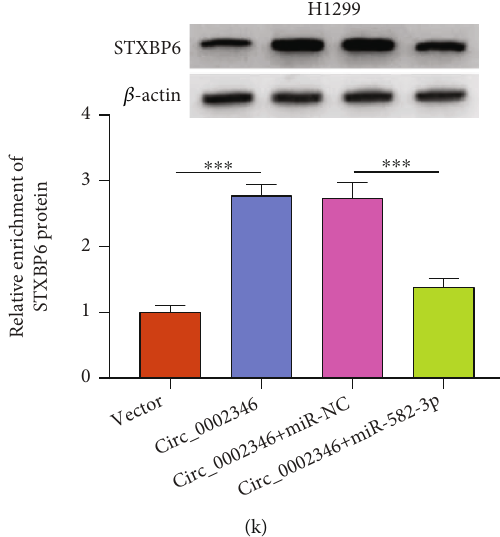
Figure 5: STXBP6 is a target of miR-582-3p. (a) The putative binding sequence between miR-582-3p and STXBP6 was predicted by the TargetScan database. (b, c) The mRNA and protein expression of STXBP6 was determined in NSCLC tissues and adjacent normal tissues by RT-qPCR and a Western blot assay. (d, e) RT-qPCR and a Western blot assay were conducted to analyze the mRNA and protein expression of STXBP6 in the NSCLC cell lines and the HBE cell line. (f, g) A dual-luciferase reporter assay was performed to verify the interaction between miR-582-3p and STXBP6. (h, i) The protein expression of STXBP6 was measured in NSCLC cells transfected with miR-NC or miR-582-3p by a Western blot assay. (j, k) NSCLC cells were transfected with circ_0002346 alone or together with miR-582-3p, and a Western blot assay was conducted to detect the protein level of STXBP6 in NSCLC cells. ∗∗∗ P < 0 : 001